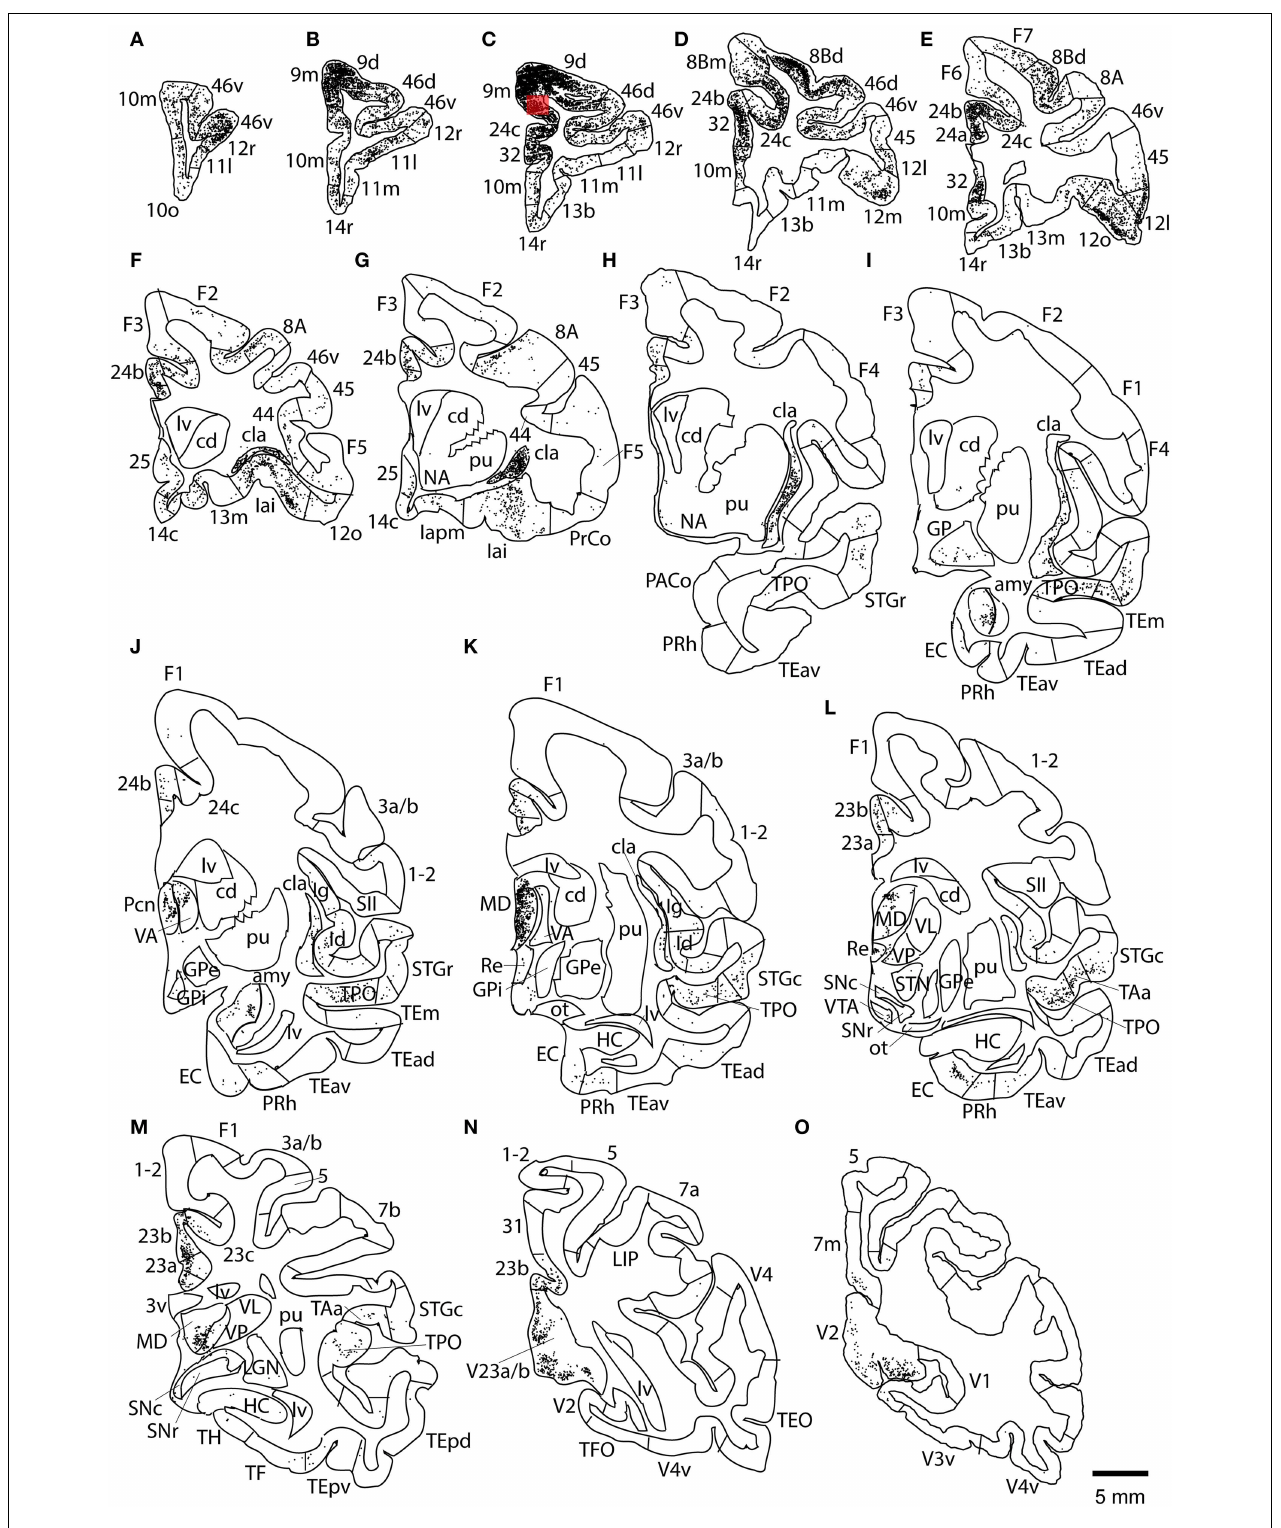
The red square indicates the injection site. The coronal sections were flipped horizontally to make the comparison between the cases